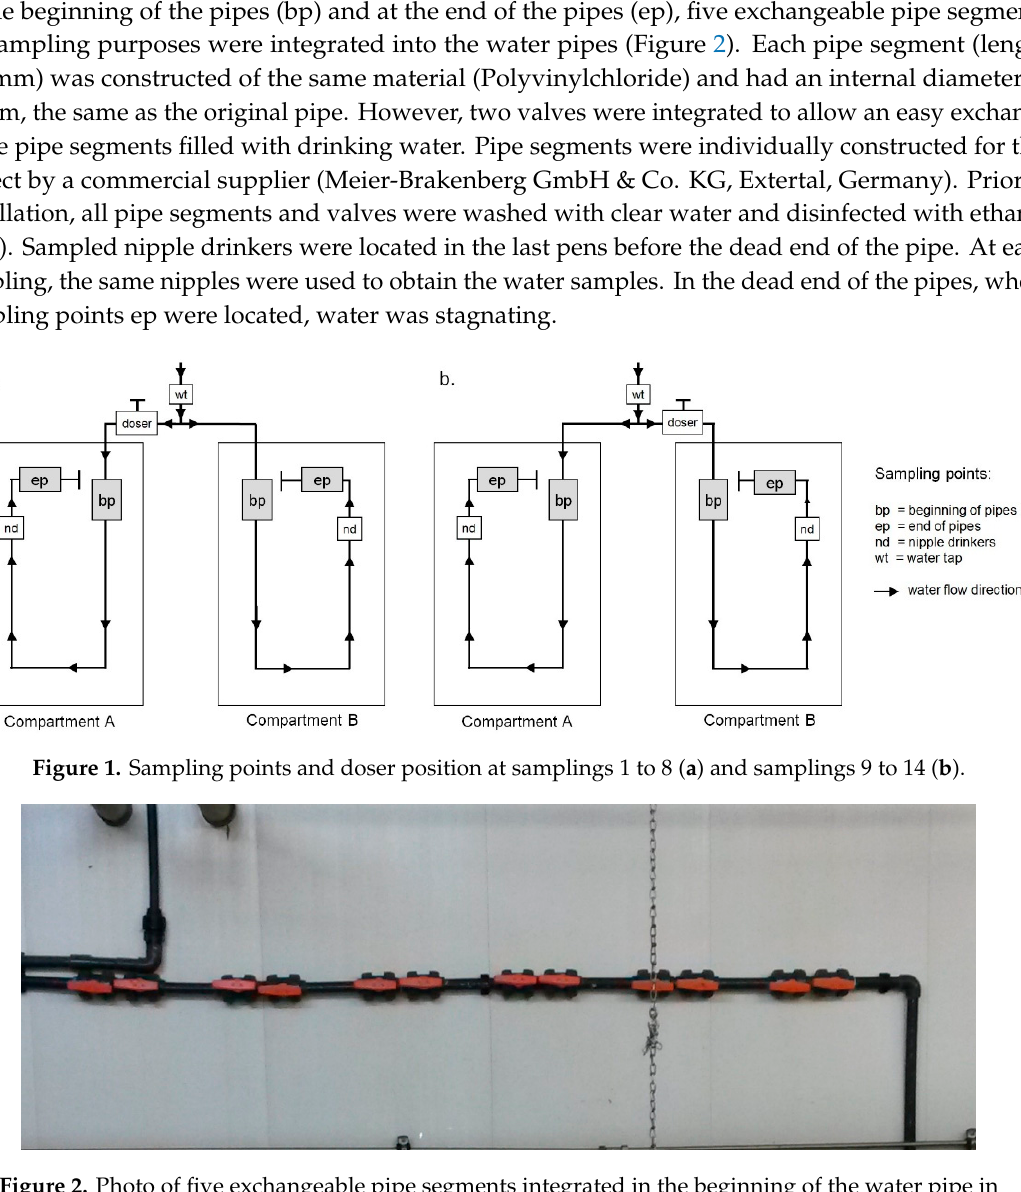
Figure 2. Photo of five exchangeable pipe segments integrated in the beginning of the water pipe in compartment B (Photo: R. Böger). Each pipe segment was located between two valves (red components) to enable an easy exchange. Water flow from left to right.